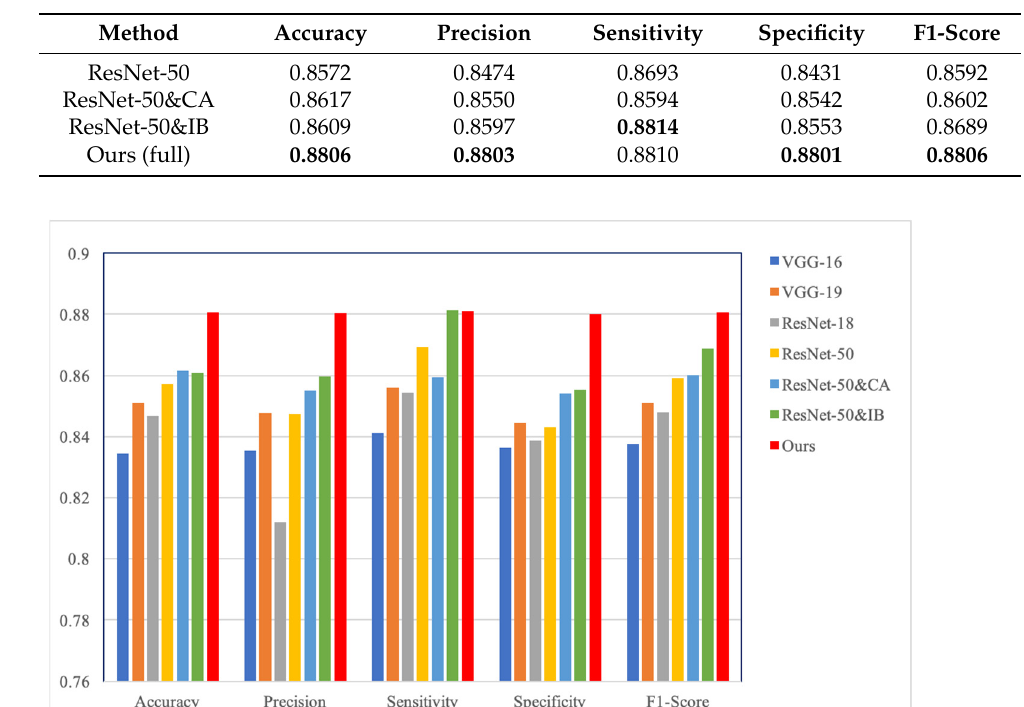
Figure 8. Comparison of classification performance between comparative experiments and ablation studies.